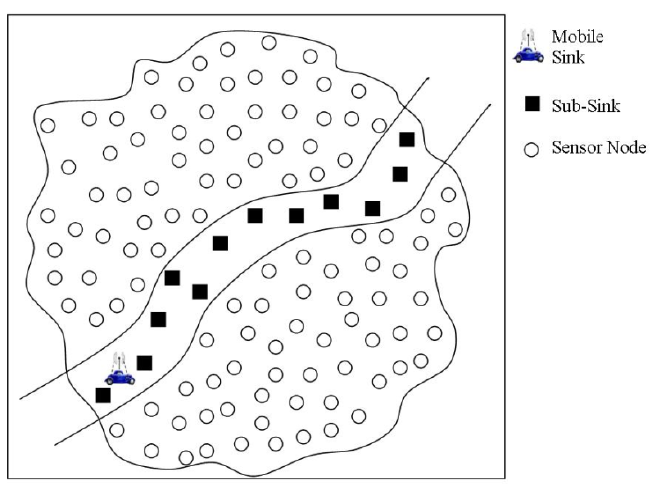
Figure 4. Strip-based structure in